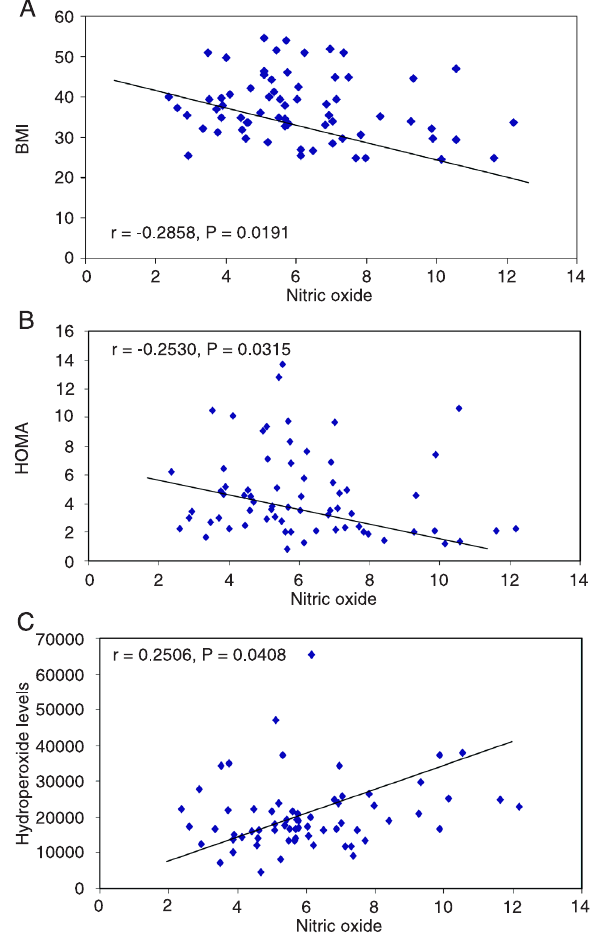
Figure 1. Dispersion graphs between serum nitric oxide levels and A , body mass index (BMI), B , homeostasis model of assess- ment (HOMA) and C , serum lipid hydroperoxide levels in patients with metabolic syndrome. Data are reported as Spearman’s cor- relation coefficients and P values.